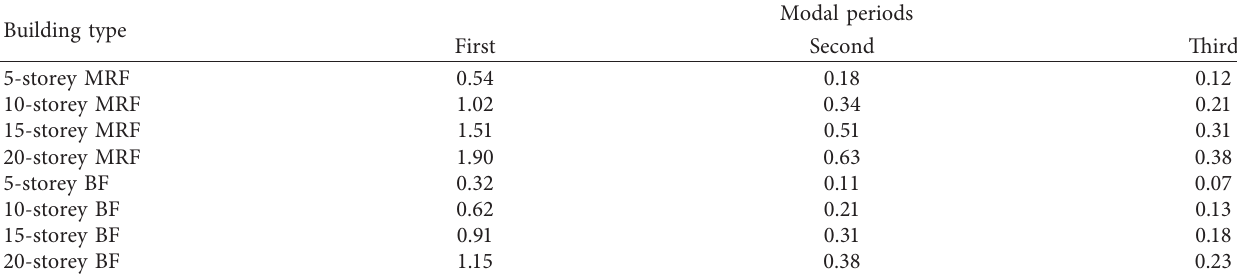
Table 2: Modal periods of the unconnected steel MRF and BF